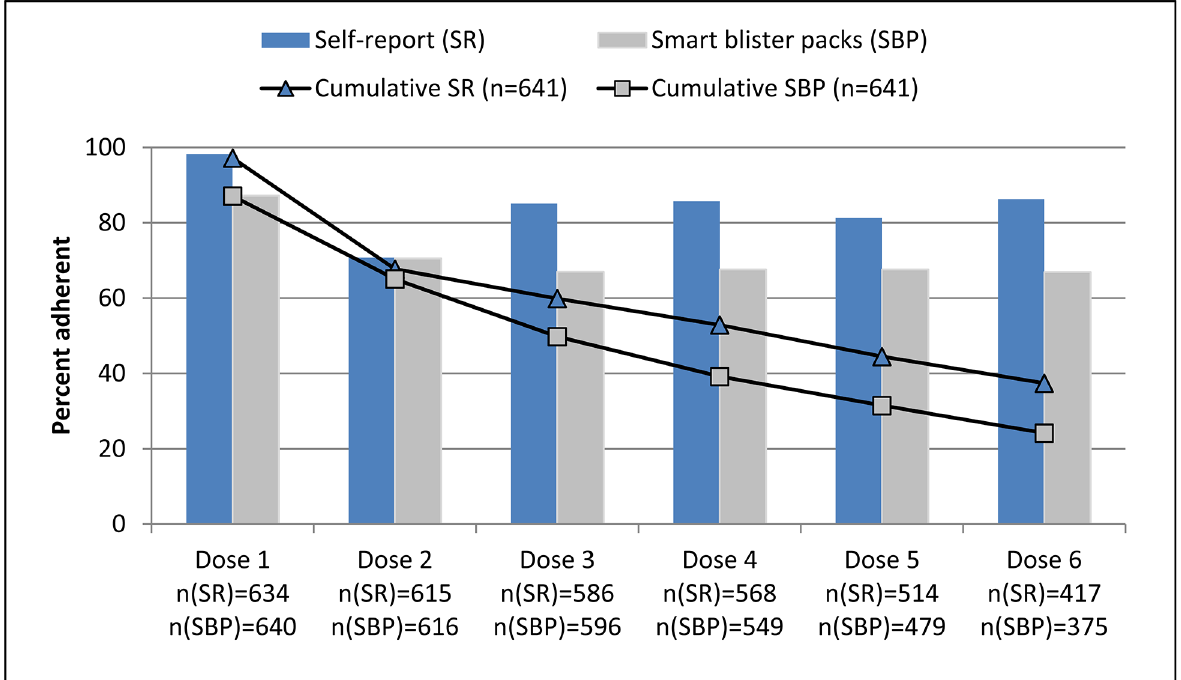
Fig 4. Timely completion for each actual dose and cumulatively 1 . 1 55 patients were excluded from this analysis because data on timing of each actual dose were not possible to assess for self-report for 18 patients and for smart blister pack data for 37